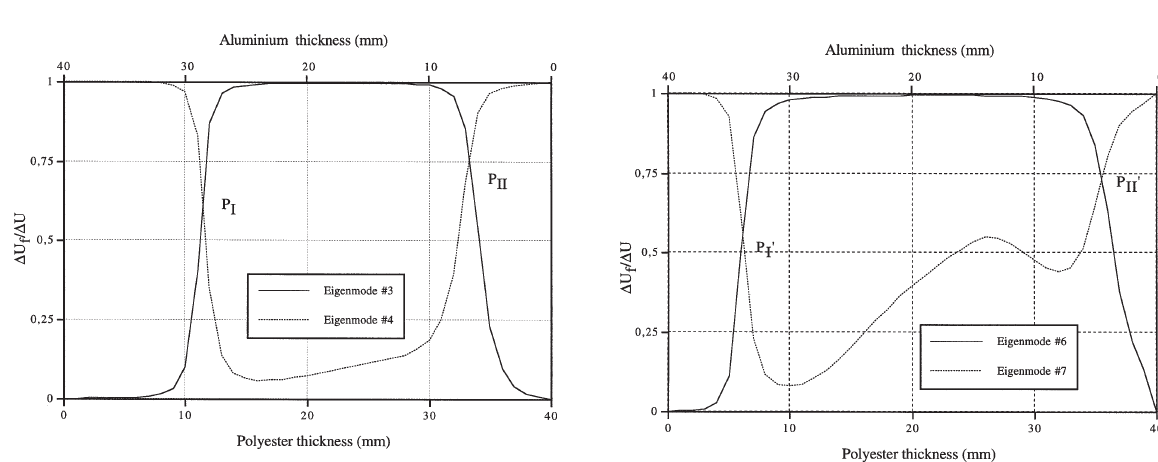
Fig. 4. Computations of damping loss factor for first longitudinal and third flexural mode.